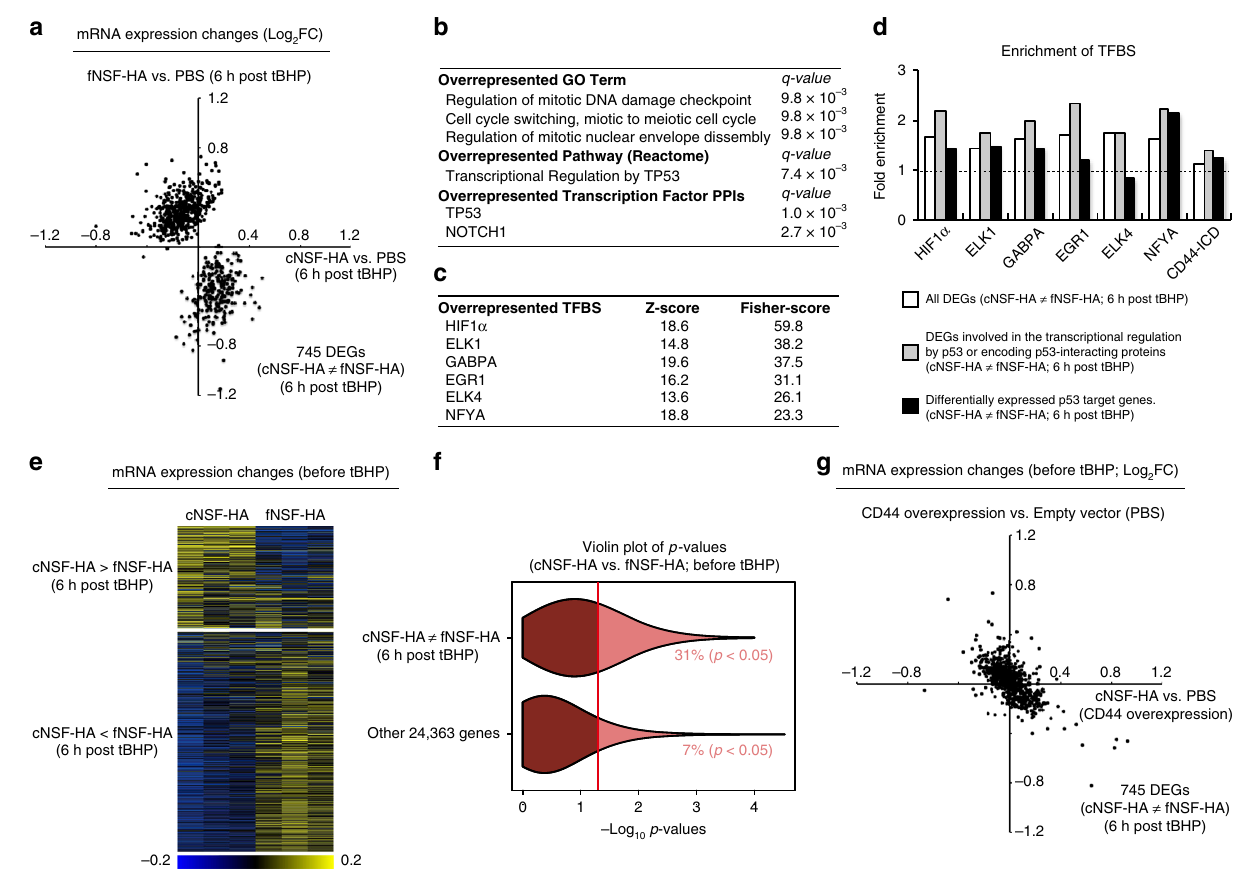
Fig. 3 Transcriptome analyses of NSF-HA-treated IMR90 cells. a Genes differentially expressed in IMR90 cells upon treatment with cNSF-HA or fNSF- HA (HA polymer length-dependent genes). Cells were pre-incubated for 6 h with 20 μ g/ml cNSF-HA, fNSF-HA, or PBS and then HA was removed and cells were exposed to 200 μ M tBHP for 1 h. Cells were collected 6 h after starting the tBHP-treatment. b Enrichment of GO Term, Reactome pathway, and transcription factor protein-protein interactions (PPIs) in the HA polymer length-dependent genes. c , d Enrichment of transcription factor binding sites (TFBS) in the HA polymer length-dependent genes. White bars represents the enrichment of TFBS in all HA polymer length-dependent genes. Gray bars represents the enrichment of TFBS in HA polymer length-dependent genes that are involved in the transcriptional regulation by p53 or encoding p53- interacting proteins. Black bars represents the enrichment of TFBS in HA polymer length-dependent p53 target genes. e Differential expression levels of the HA polymer length-dependent genes (de fi ned in the presence of tBHP) in IMR90 cells incubated for 6 h with 20 μ g/ml cNSF-HA, fNSF-HA, or PBS. f The violin plot represents the distribution of p -values of a two-tailed t -test comparing the gene expression levels of the HA polymer length-dependent genes and HA-polymer length-independent genes (de fi ned in the presence of tBHP) between cNSF-HA- and fNSF-HA-incubated IMR90 cells. Cells were incubated for 6 h with 20 μ g/ml cNSF-HA or fNSF-HA without further tBHP-treatment. g Differential expression levels of the HA polymer length- dependent genes (de fi ned in the presence of tBHP) in control and CD44-overexpressing IMR90 cells incubated for 6 h with 20 μ g/ml cNSF-HA or